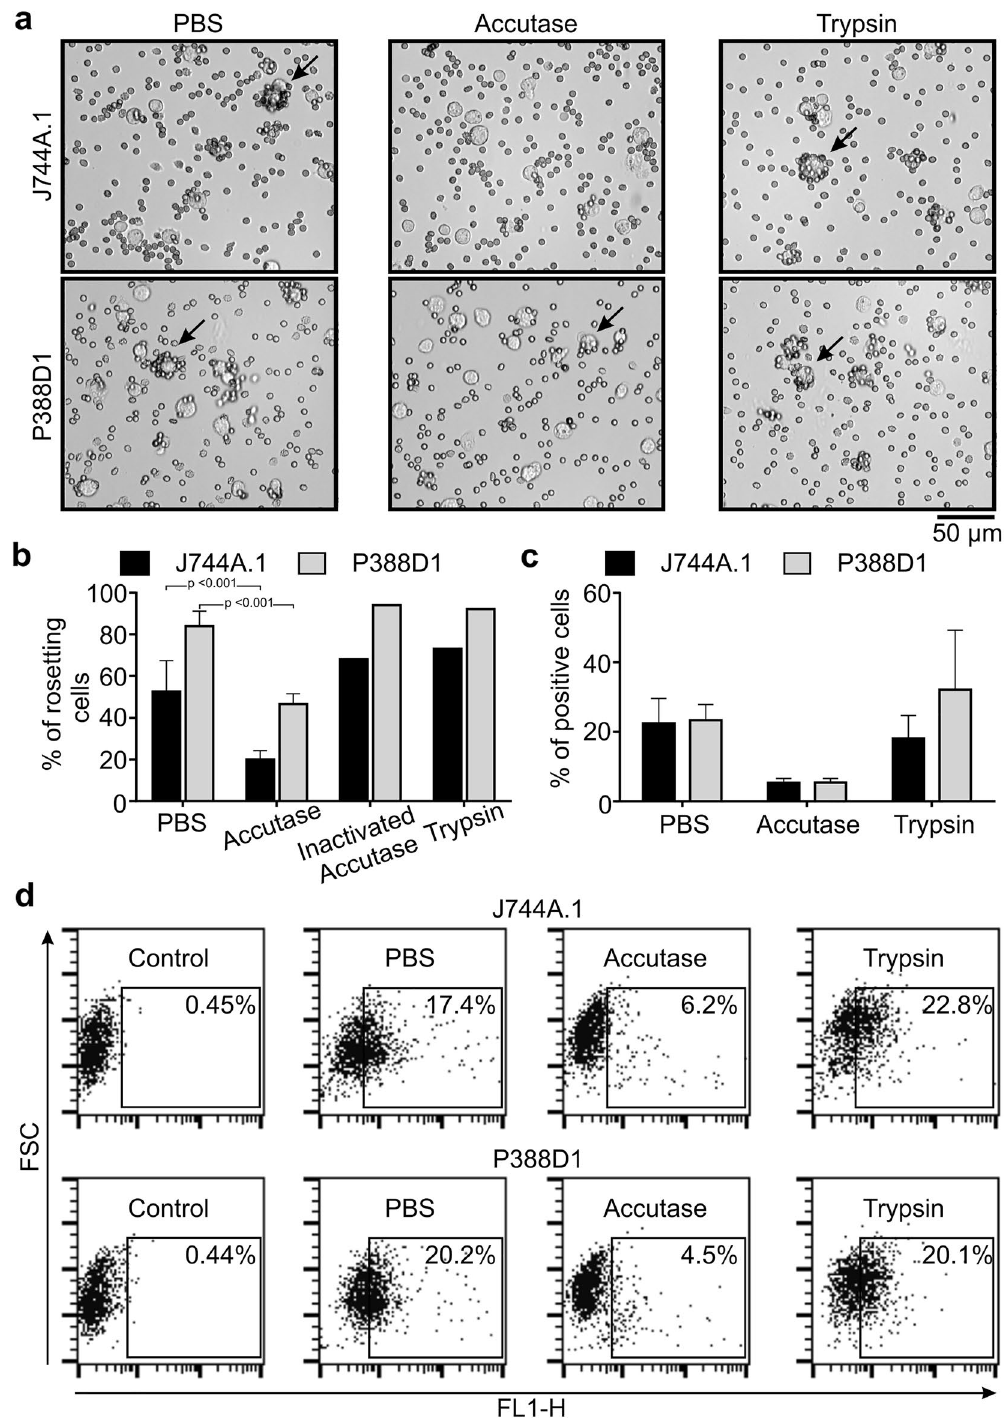
Figure 2. Binding of mIgG3 to J774A.1 and P388D1 is diminished after Accutase treatment of the cells. ( a , b ) Rosetting of erythrocytes around J774A.1 and P388D1 cells was induced by mIgG3 M18 specific to antigen B of the human ABO blood group system. Control and protease-treated cells were coated with M18 mIgG3 and then incubated with group B erythrocytes. ( a ) Representative microscope images of three independent experiments are shown. The arrows point to exemplary rosettes. ( b ) The chart presents average values ± SD from two independent rosetting experiments performed for the negative control (PBS) and Accutase treatment and from one experiment performed for inactivated Accutase and trypsin. Three randomly chosen fields were analyzed for each sample in each experiment. ( c , d ) Flow cytometry analysis of M18-488 binding to J774A.1 or P388D1 cells. The cells were treated with the enzymes and then stained with fluorescently labeled M18-488. ( c ) Average values ± SD from two independent experiments are shown. ( d ) Representative dot plots from the flow cytometry analysis. ( a – d ) The clone #12 of P388D1 was used in these